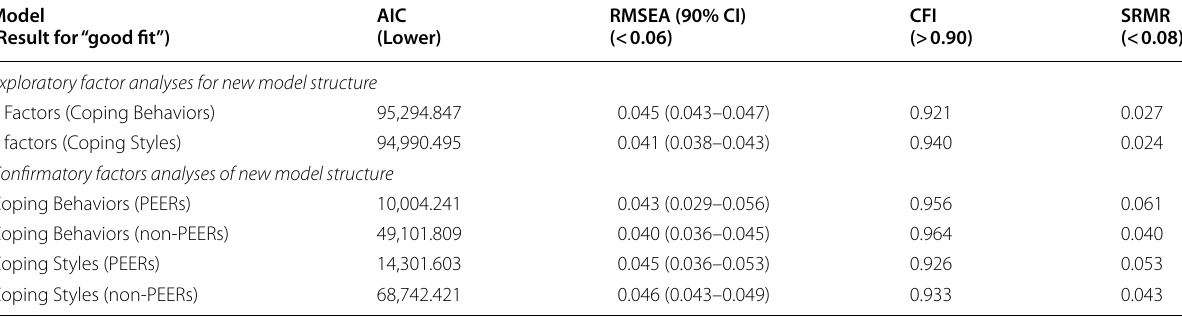
Table 2 Model fit